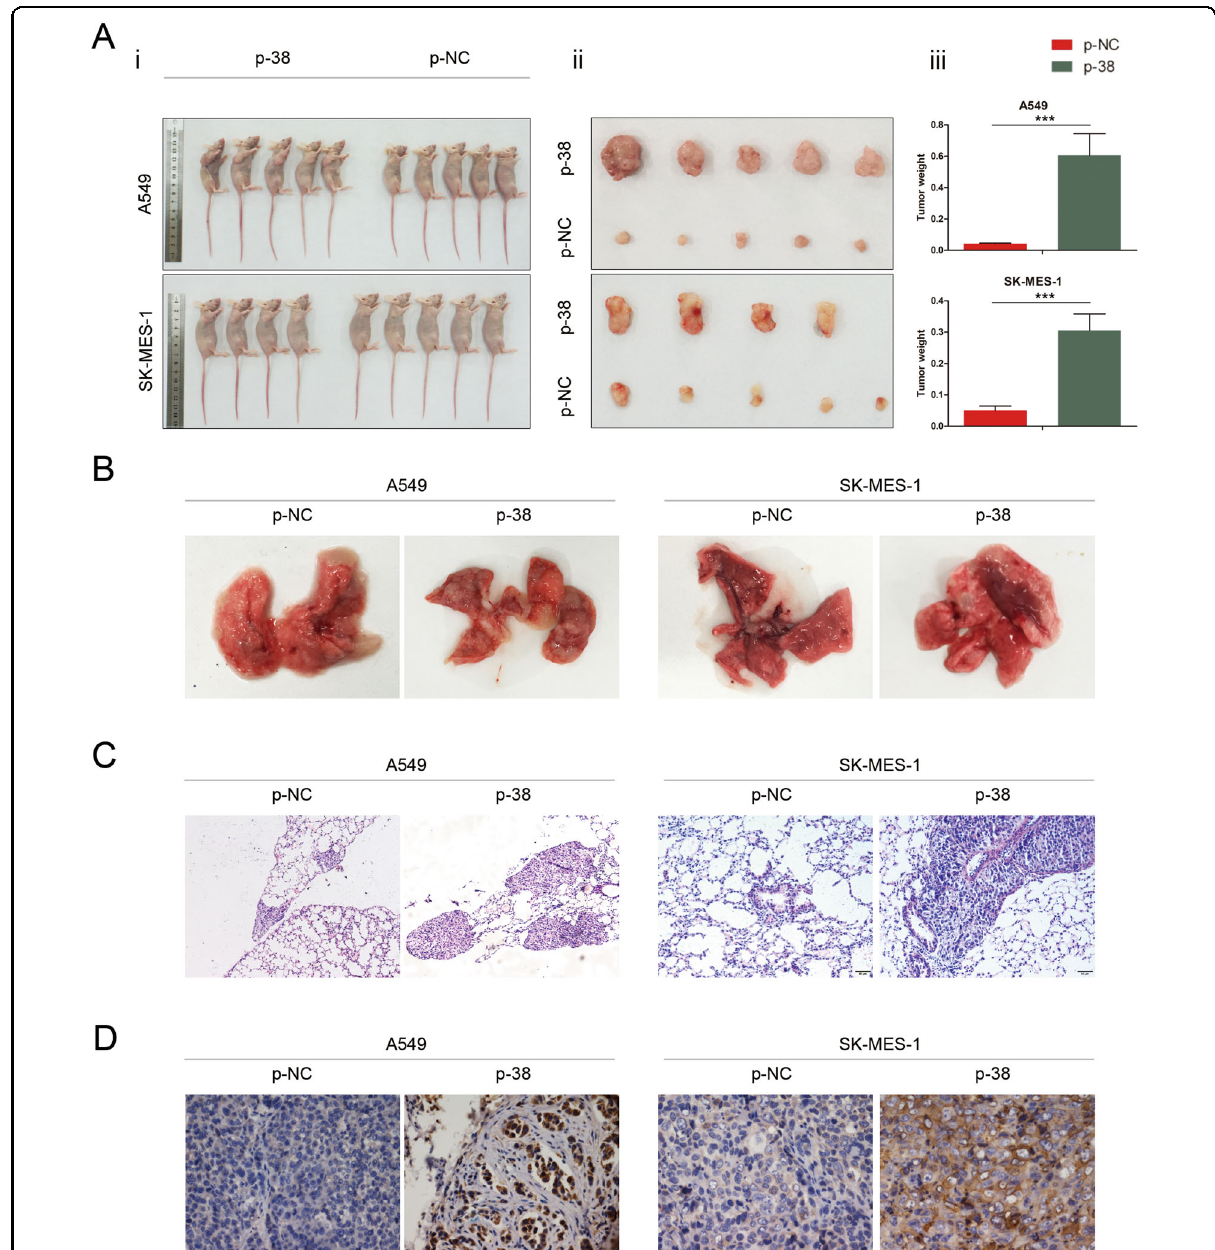
Fig. 6 KLHL38 in fl uences cell proliferation, migration, and invasion in vivo. A Xenograft tumor volumes were positively affected by KLHL38, i. Comparison of gross photos of nude mice; ii. Gross picture of subcutaneous tumor; iii. Histograms of subcutaneous tumorigenesis. B Mice injected with lung cancer cells overexpressing KLHL38 showed enhanced pulmonary metastases compared to the control group. C Hematoxylin and eosin staining of metastatic tumor tissues. Magni fi cation: ×200 . D KLHL38 staining of metastatic tumors by immunohistochemistry. Magni fi cation: ×400. p-NC, cells transfected with pCMV6-myc-DDK; p-38, cells transfected with pCMV6-myc-DDK- KLHL38 . Error bars as